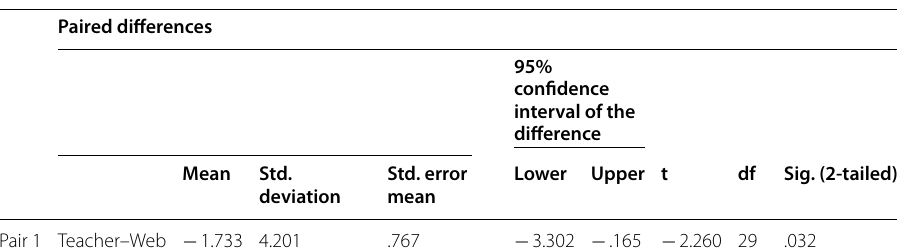
Table 6 Paired Samples